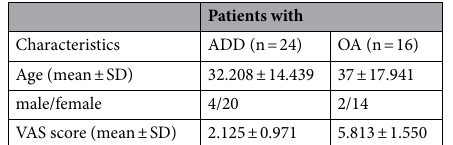
Table 1. Demographic and clinical characteristics of patients with TMJ ADD and